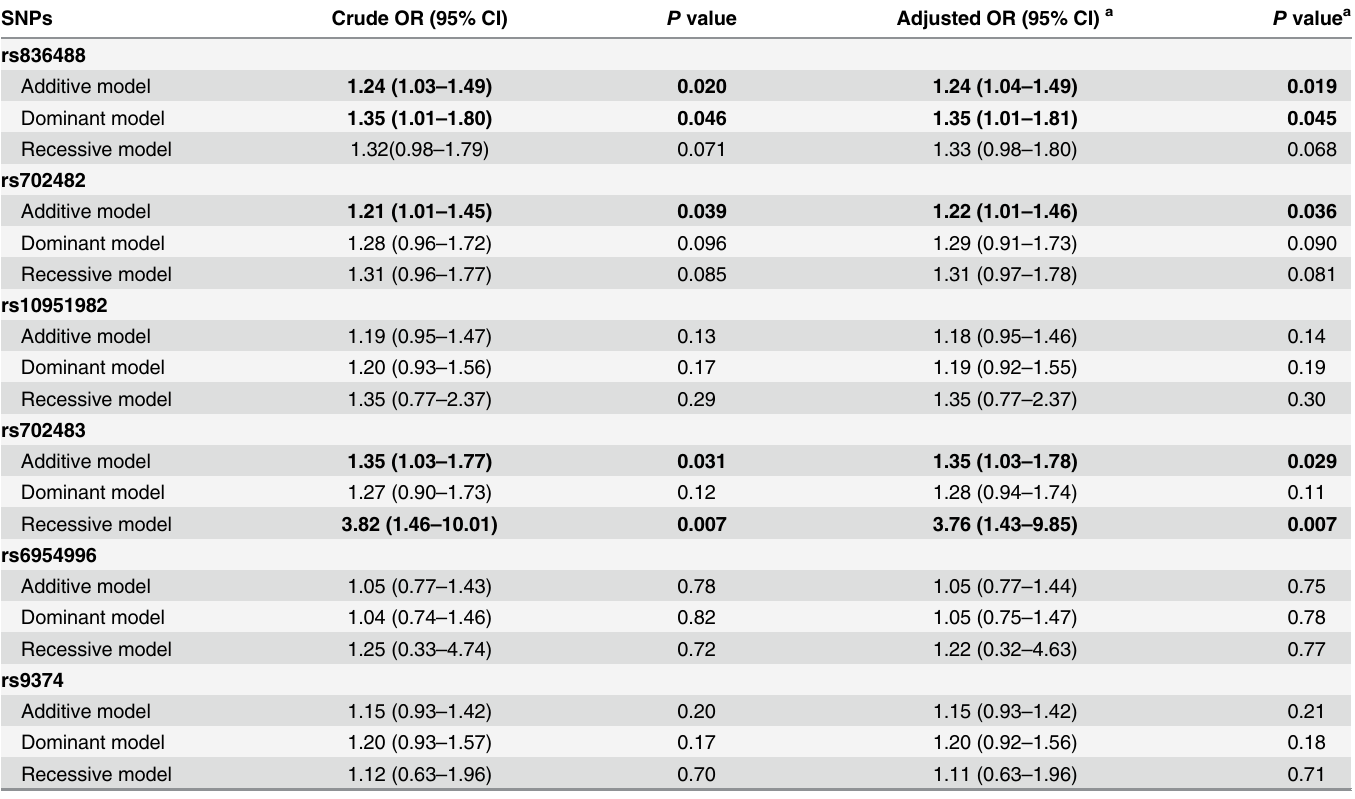
Table 4. Analysis of the six SNPs based on three genetic